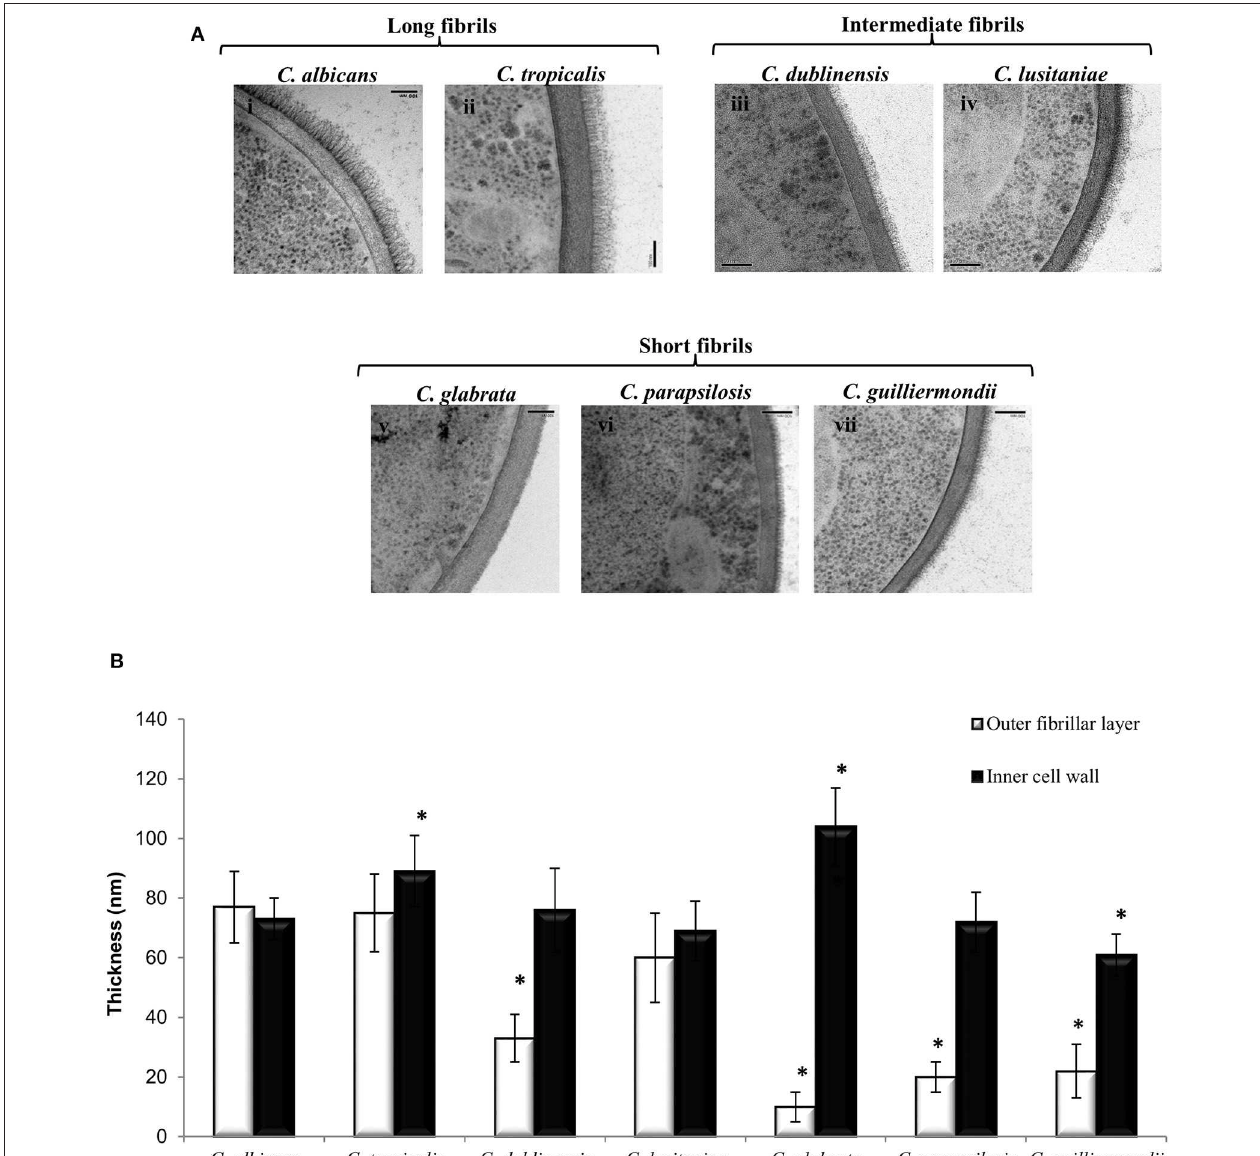
FIGURE 1 | The ultrastructure of the cell wall varies between Candida species. (A) TEMs of the cell wall of different Candida species: C. albicans (i) , C. tropicalis (ii), C. dublinensis (iii), C. lusitaniae (iv), C. glabrata (v), C. parapsilosis (vi) and C. guilliermondii (vii). Scale bars are 100nm. (B) The thickness of the inner cell wall (glucan and chitin) and outer fibrillar layer was determined from TEM pictures. Measurements from 30 cells that were sectioned so that cell wall thickness was even all around the cell periphery. Significant differences (* p < 0.05) compared to C. albicans . Error bars are SD ( n = 30).